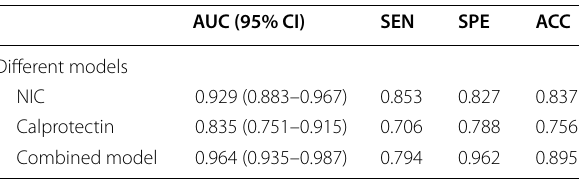
Table 4 Performance of the NIC, calprotectin and combined models for predicting MH